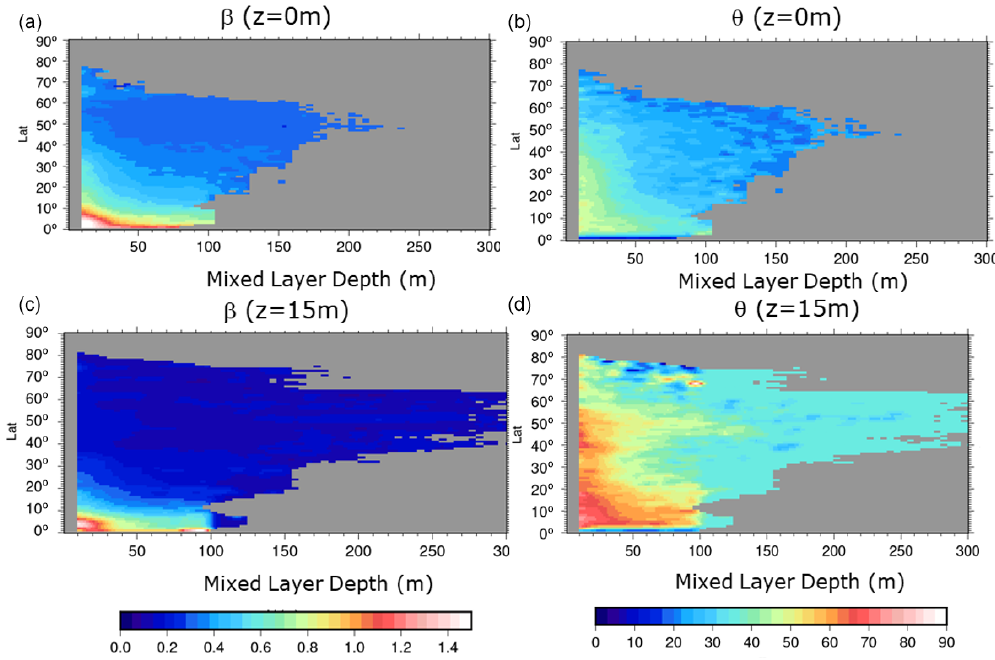
Figure 3. The β (a, c) and θ (b, d) parameters calculated in this study as a function of mixed layer depth and | latitude | . The (a, b) ( c, d ) plots show the parameters at the surface (15m depth). Only bins with more than 50 values are shown. Table 1. Percentage of variance explained by the surface wind-driven